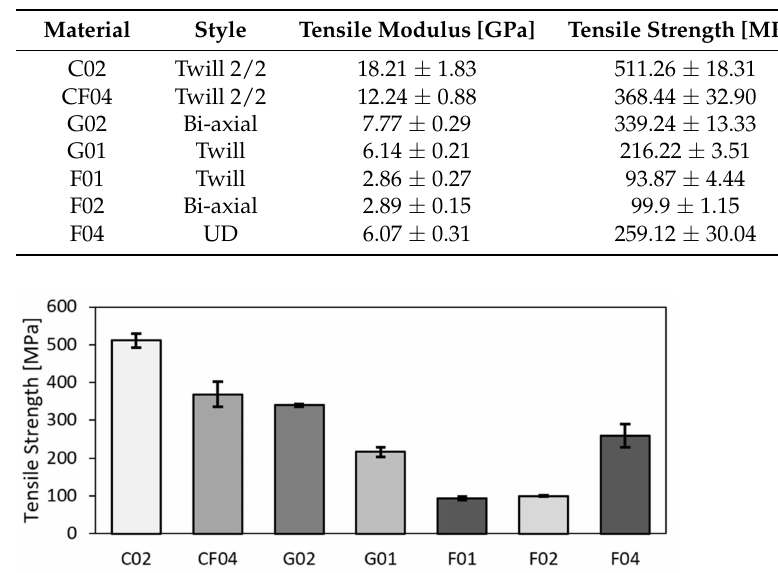
Table 4. Tensile properties of samples.